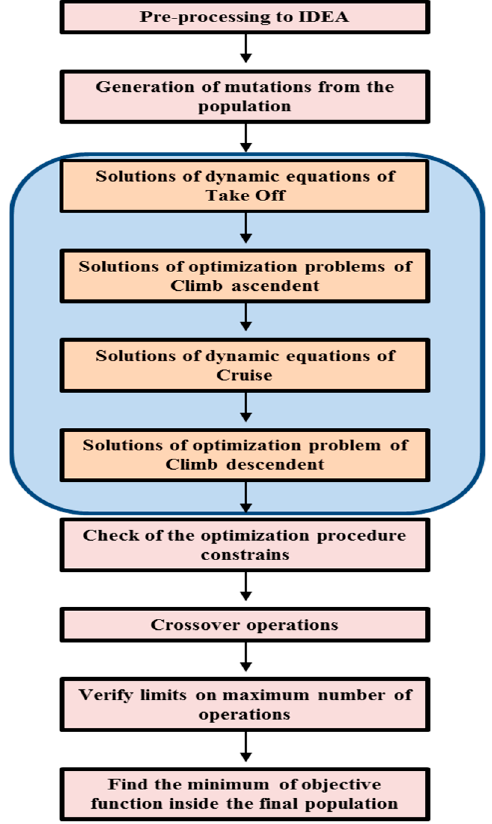
Figure 4. Flow chart of the optimized procedure solutions of dynamics equations of take-off.